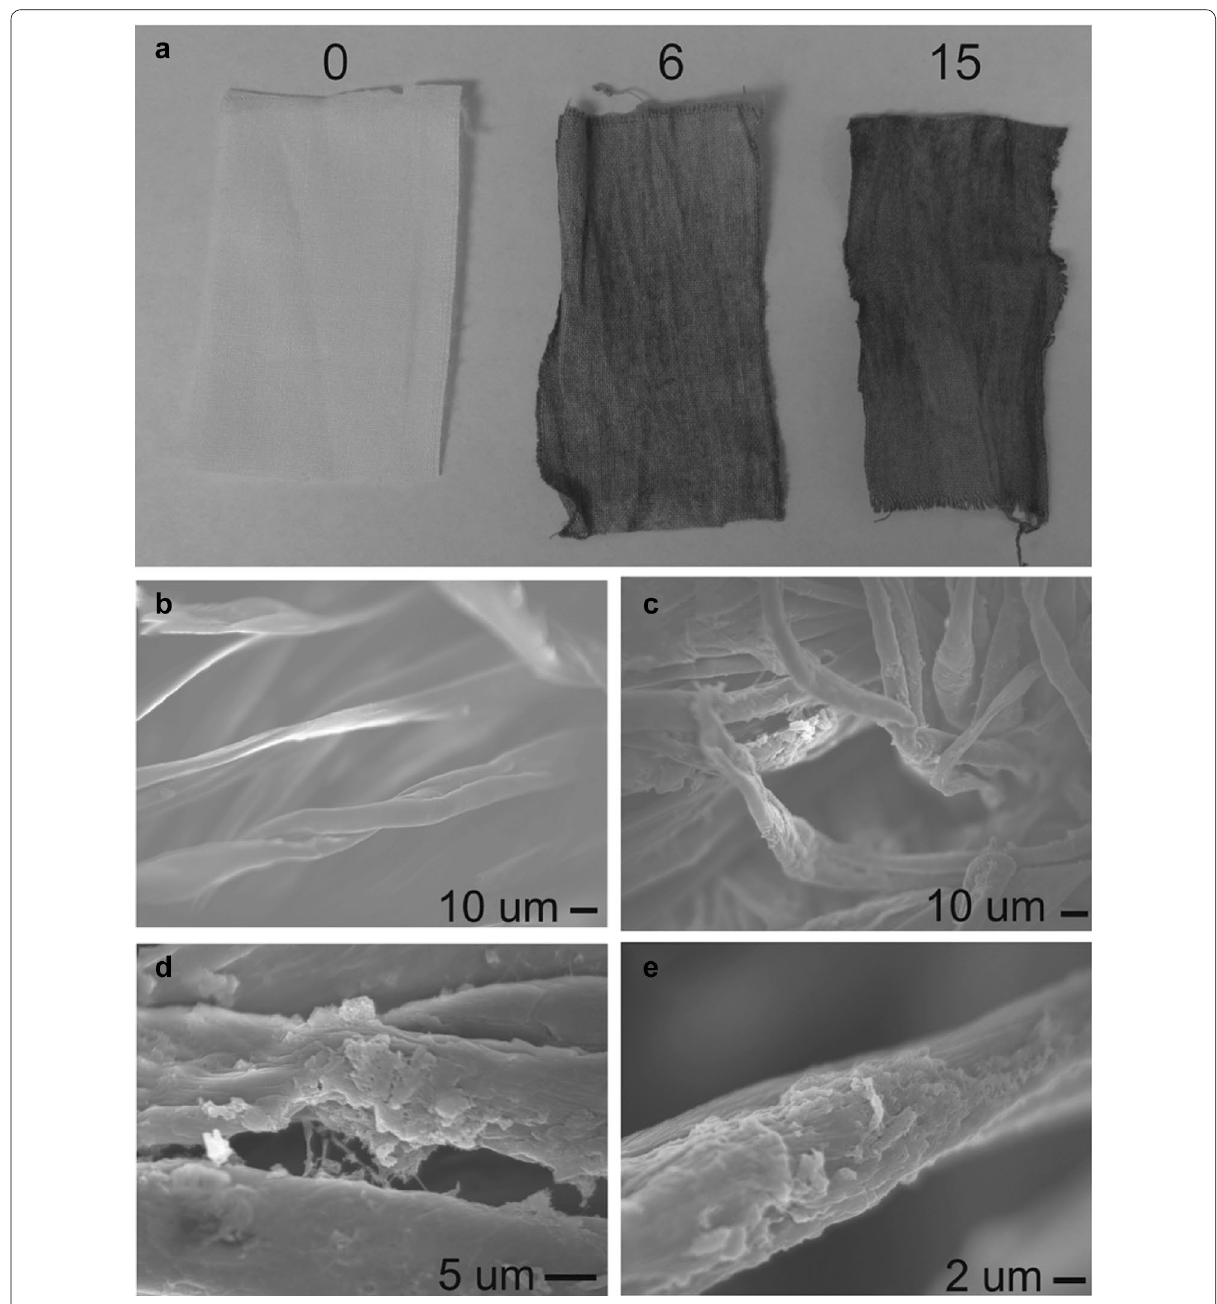
Fig. 6 a Digital image of PANI NF/GO LbL films on cotton fabric, from left to right (0, 6, and 15 layer pairs). SEM images of b bare cotton fabric and c – e 15 layer pairs of PANI NF/GO on cotton fabric (Reprinted with permission